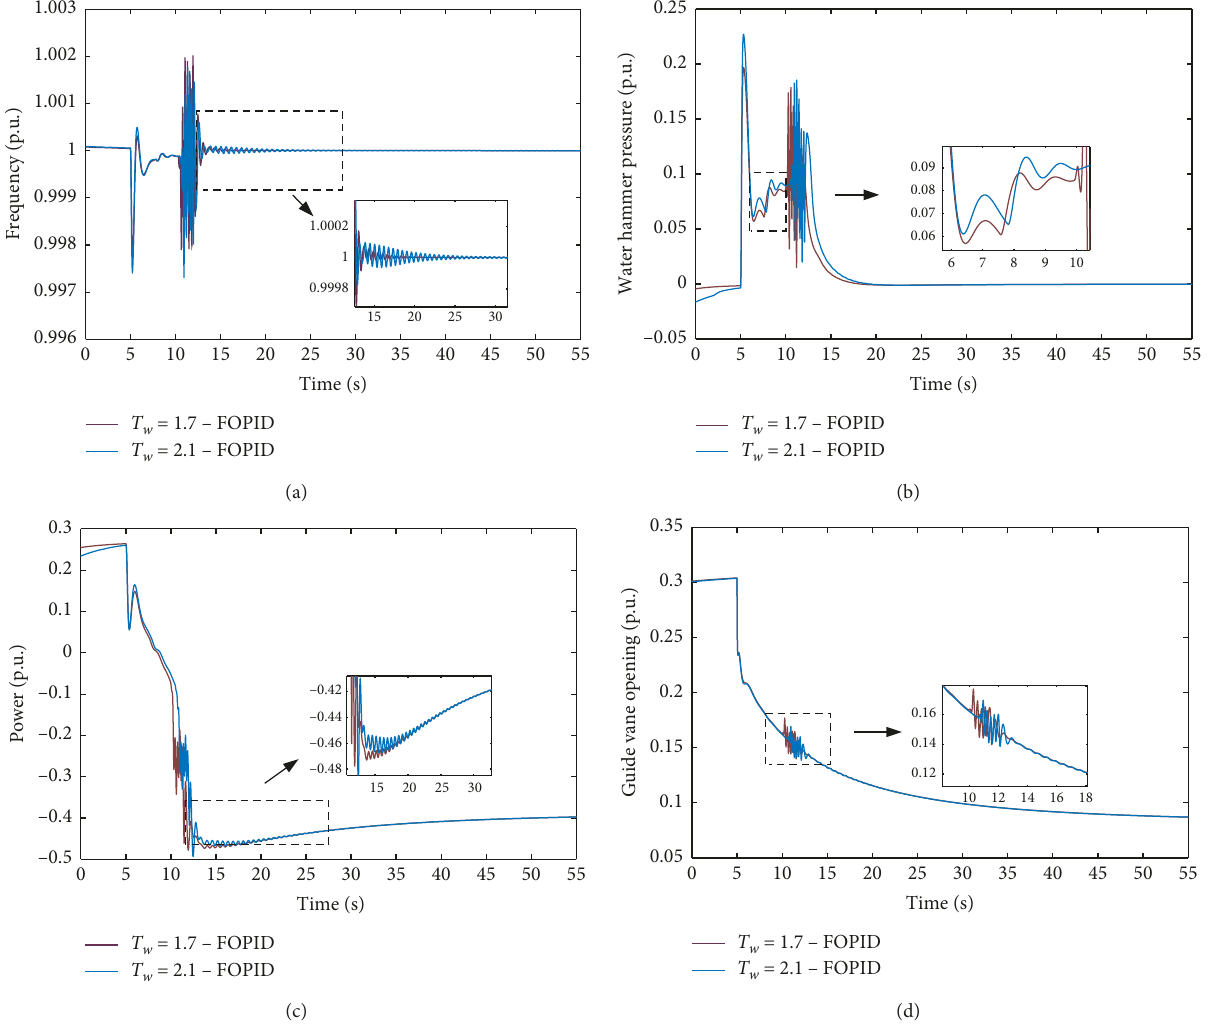
Figure 13: Dynamic response of each output at different T Guide vane